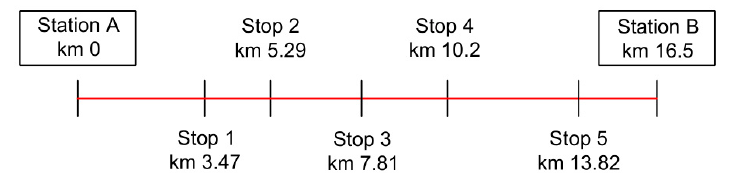
Figure 8. Stops between Station A and Station B.